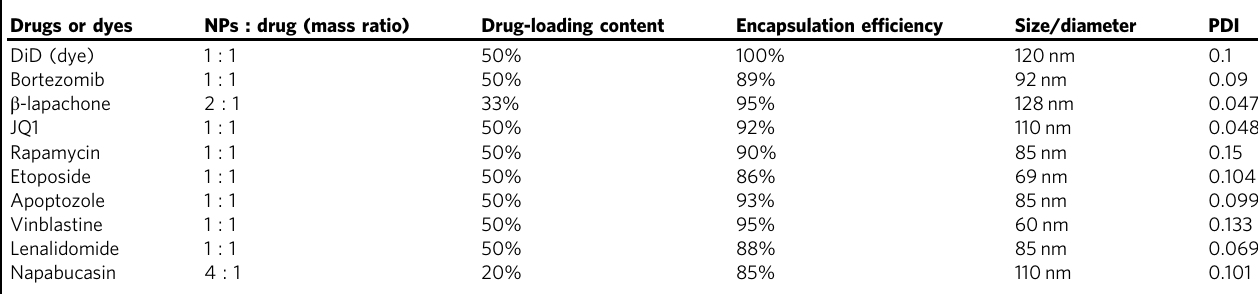
Fig. 2 Characterisation of BAQ ONNs. a Size change of BAQ NPs (10 µ M) in acetate buffer with different pH values; data are mean values ± SD; n = 3 independent nanoparticle samples. b The pH-dependent haemolysis induced by BAQ NPs (50 µ M, 4 h) in PBS buffer; data are mean values± SD; n = 3 independent nanoparticle samples. c The pH change of BAQ NPs (1 mM) within hydrochloric acid (HCl, 0.1 M) titration. d , e Representative TEM micrograph at pH 7.4 ( d ) and pH 5.0 ( e ); the insets display the size distribution (left) and Tyndall effect (right); experiments were all repeated three times independently. f In vitro drug releasing patterns at pH 7.4 and pH 5.0; data are mean values ± SD; n = 3 independent nanoparticle samples. g The count rate for various concentrations of BAQ NPs in water; The intersection of two lines refers to CACs of BAQ12 NPs (0.45 µ g mL − 1 , 0.76 µ M) and BAQ13 NPs (0.15 µ g mL − 1 , 0.25 µ M); data are mean values± SD; n = 3 independent nanoparticle samples. Table 2 Parameters of drug loading using BAQ13